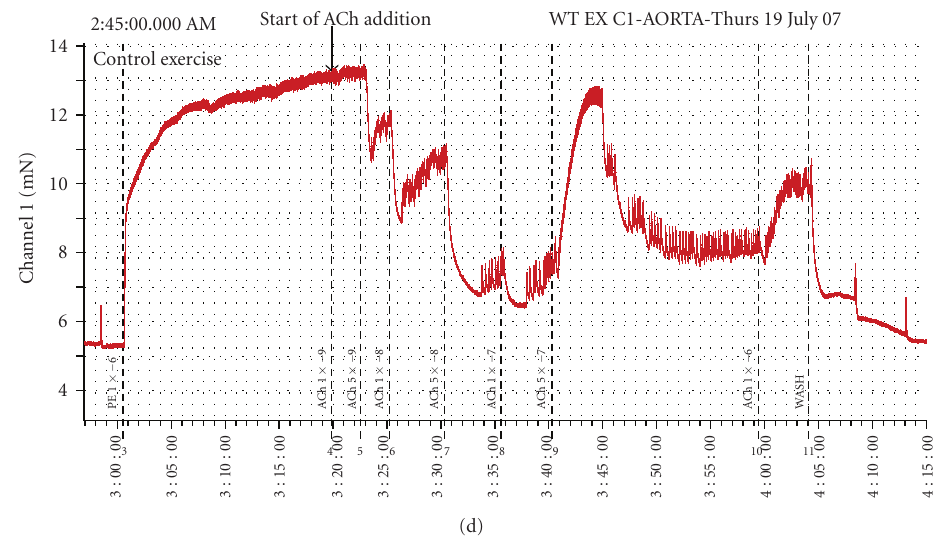
Figure 1: Representative traces showing ACh-induced vasodilation in aortae from diabetic (db/db) and control mice that were either sedentary or exercised.